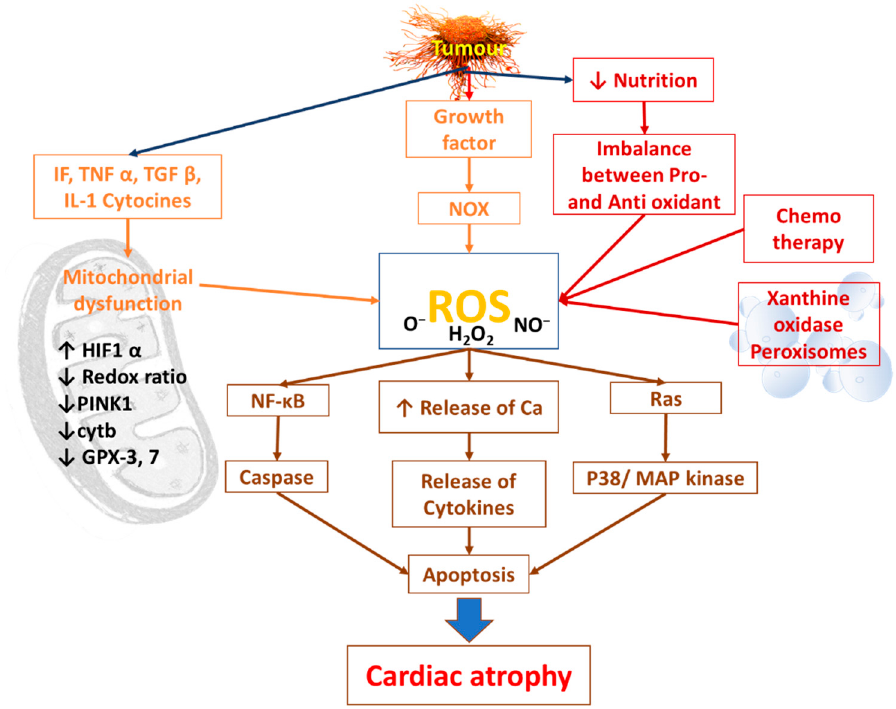
Figure 3. Diagram showing different sources of reactive oxygen species (ROS) and its probable mechanism for the induction of cardiac atrophy in cancer patients. NOX: NADPH oxidase, cyt b: cytochrome b, GPX-3, 7: glutathione peroxidase 3 and glutathione peroxidase 7, HIF1 α : hypoxia inducible factor, PINK1: PTEN induced kinase1. “ ↑ ” denotes increase. “ ↓ ” denotes decrease. Redrawn with modification from ref [37] under Attribution License (CC BY 4.0).